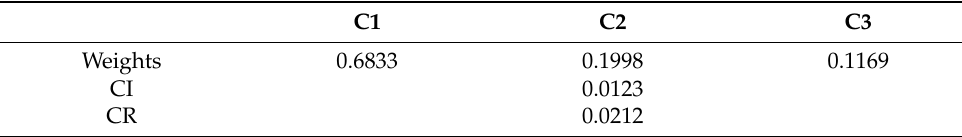
Table 1. The AHP with the crisp weights and consistent indexes. C1 C2 C3 Weights